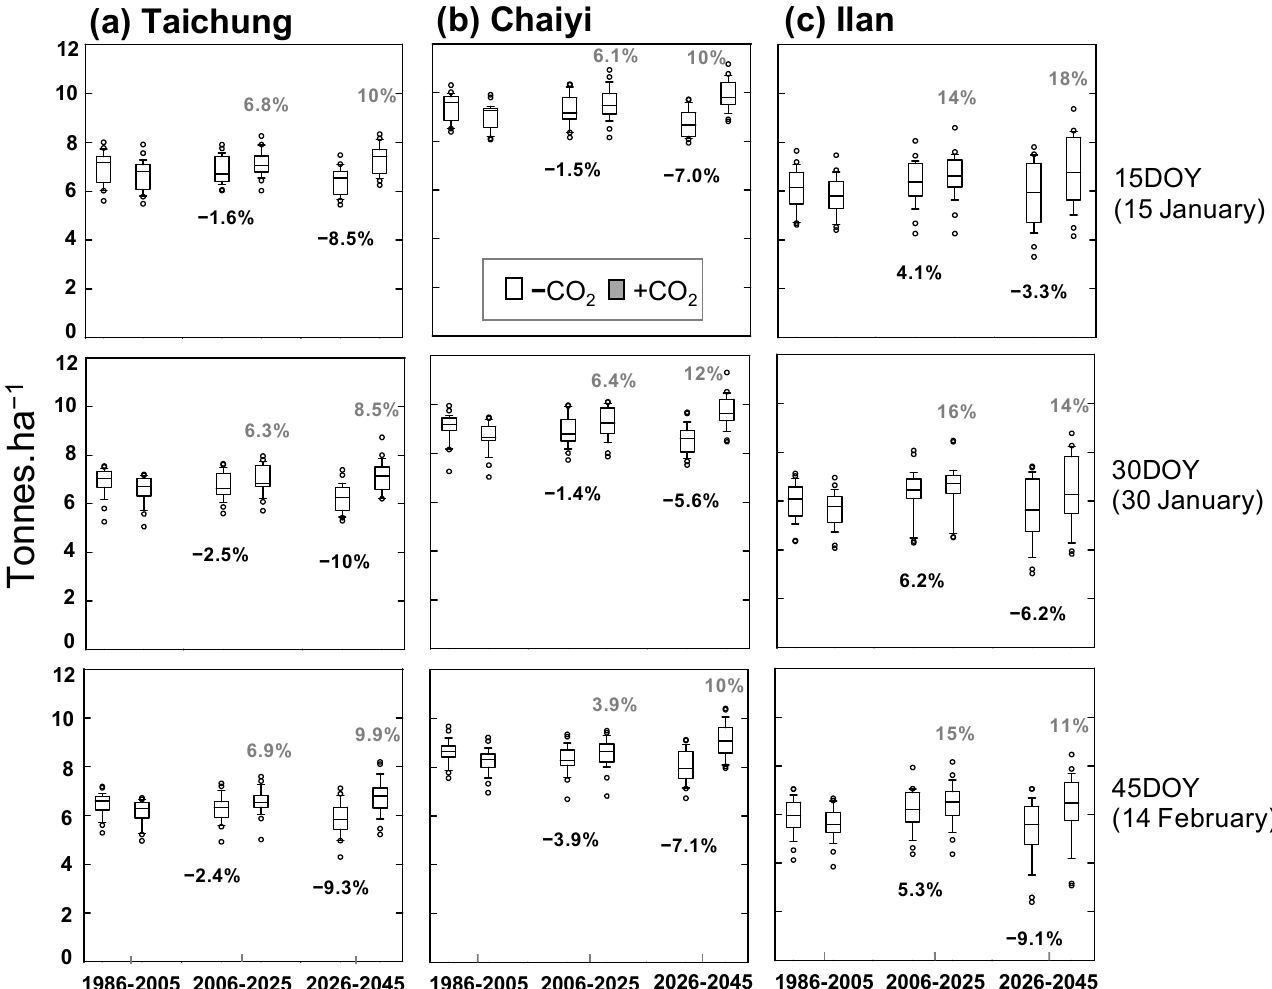
Figure 8. Simulated yield (with and without projected CO 2 ) for three planting dates (15, 30, 45 day of year) and three periods (1986–2005, 2006–2025, 2026–2045) constructed for ( a ) Taichung, ( b ) Chaiyi, and ( c ) Ilan; numbers indicate percentage of averaged ‐ yield change compared to historical period (1986–2005).